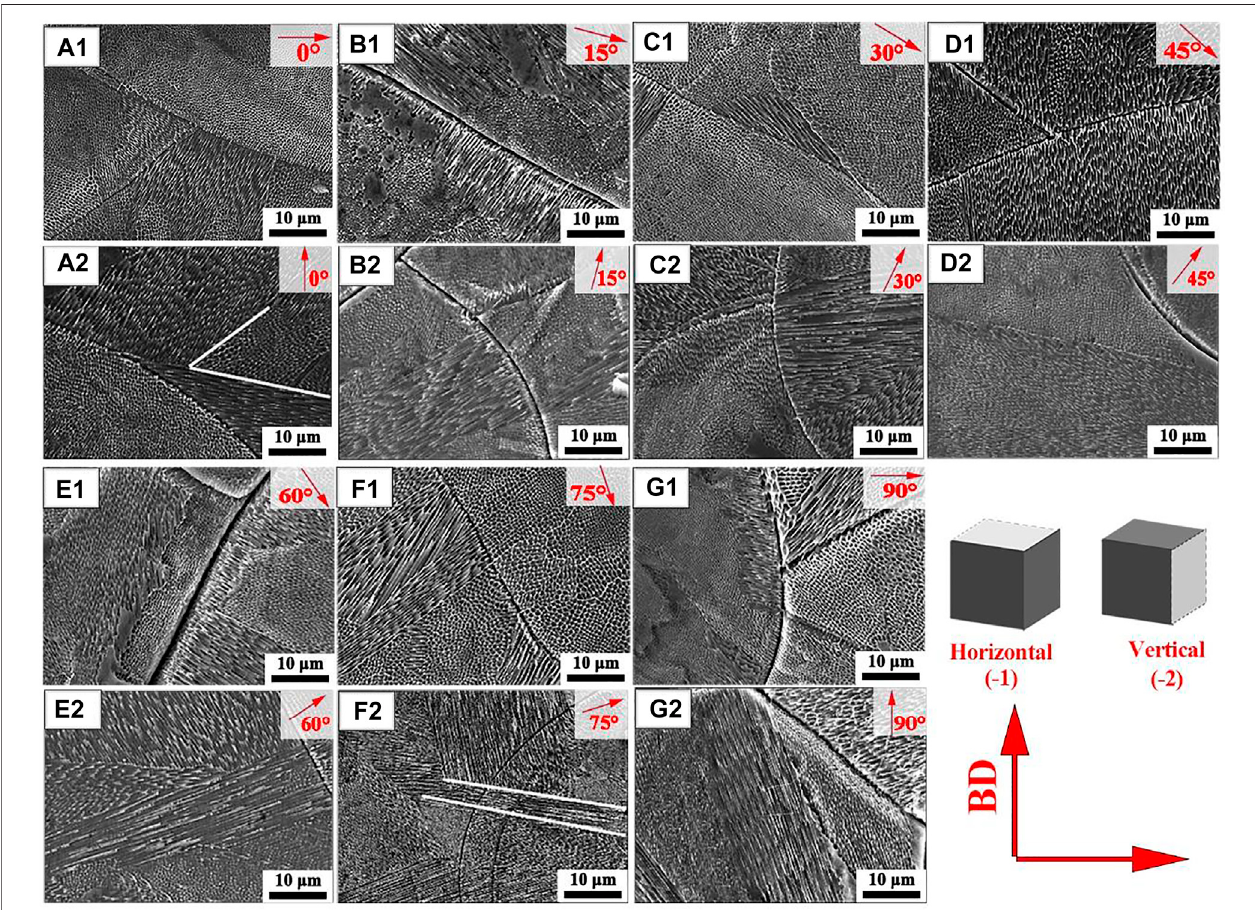
FIGURE3| SEMimagesofSLM-processed316LSSwithfromdifferentanglesrelativetothebuildsubstrate: (a 1 -g 1 )crosssectionand (a 2 -g 2 )longitudinalsection.